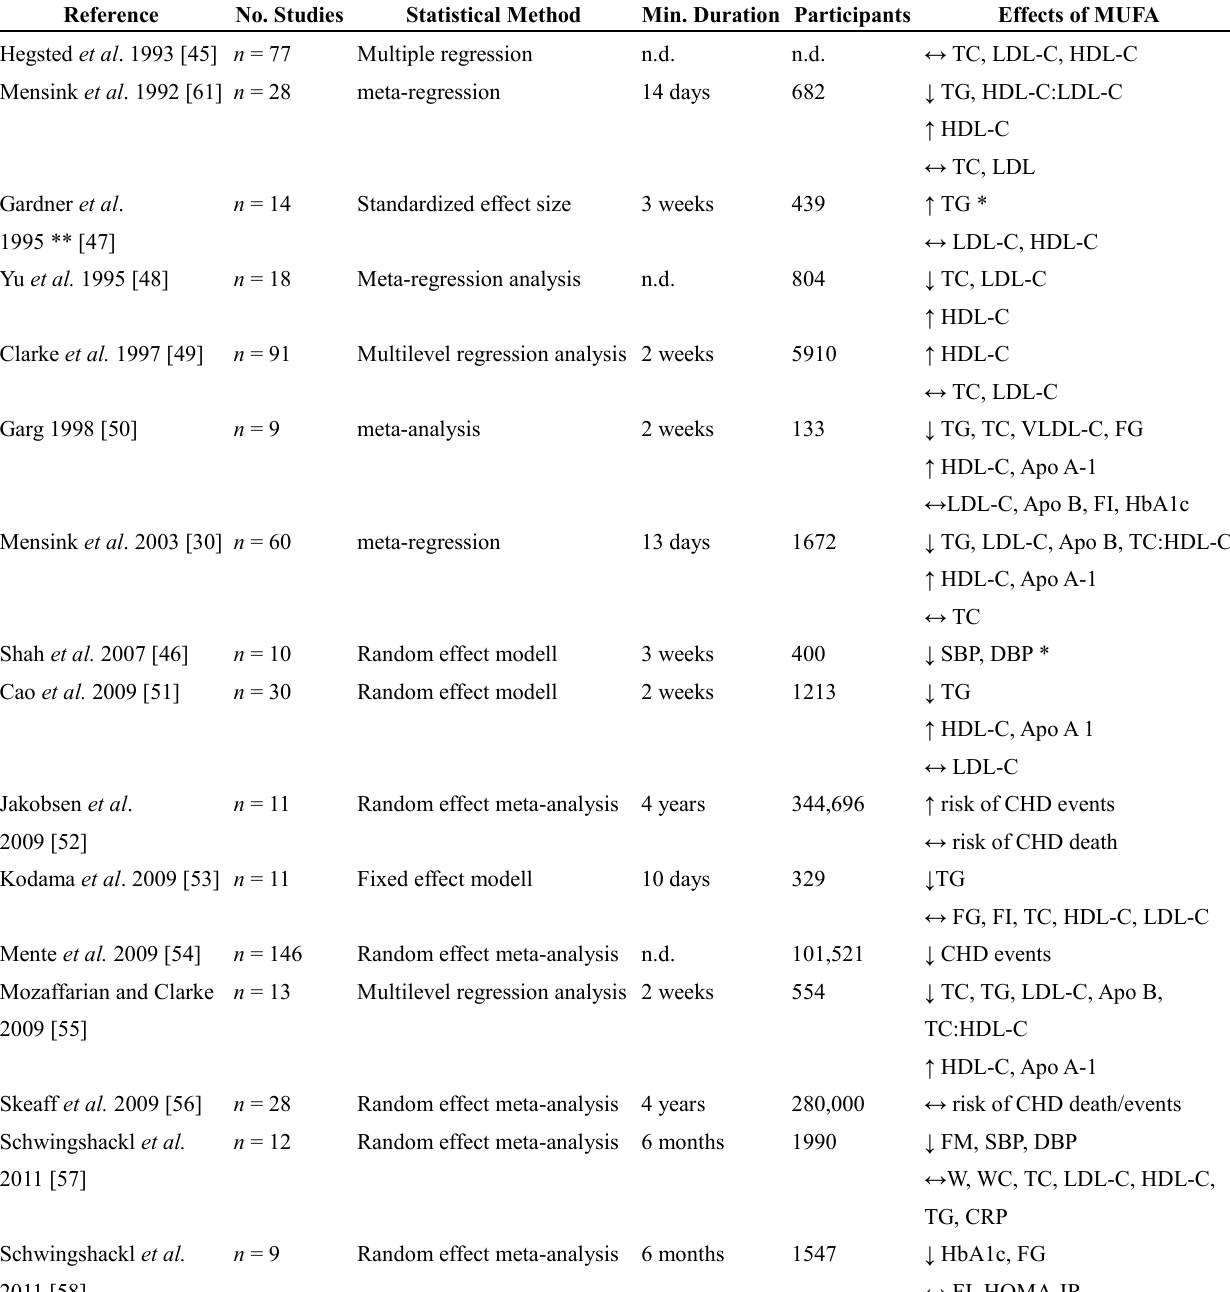
Table 5. Study characteristics of